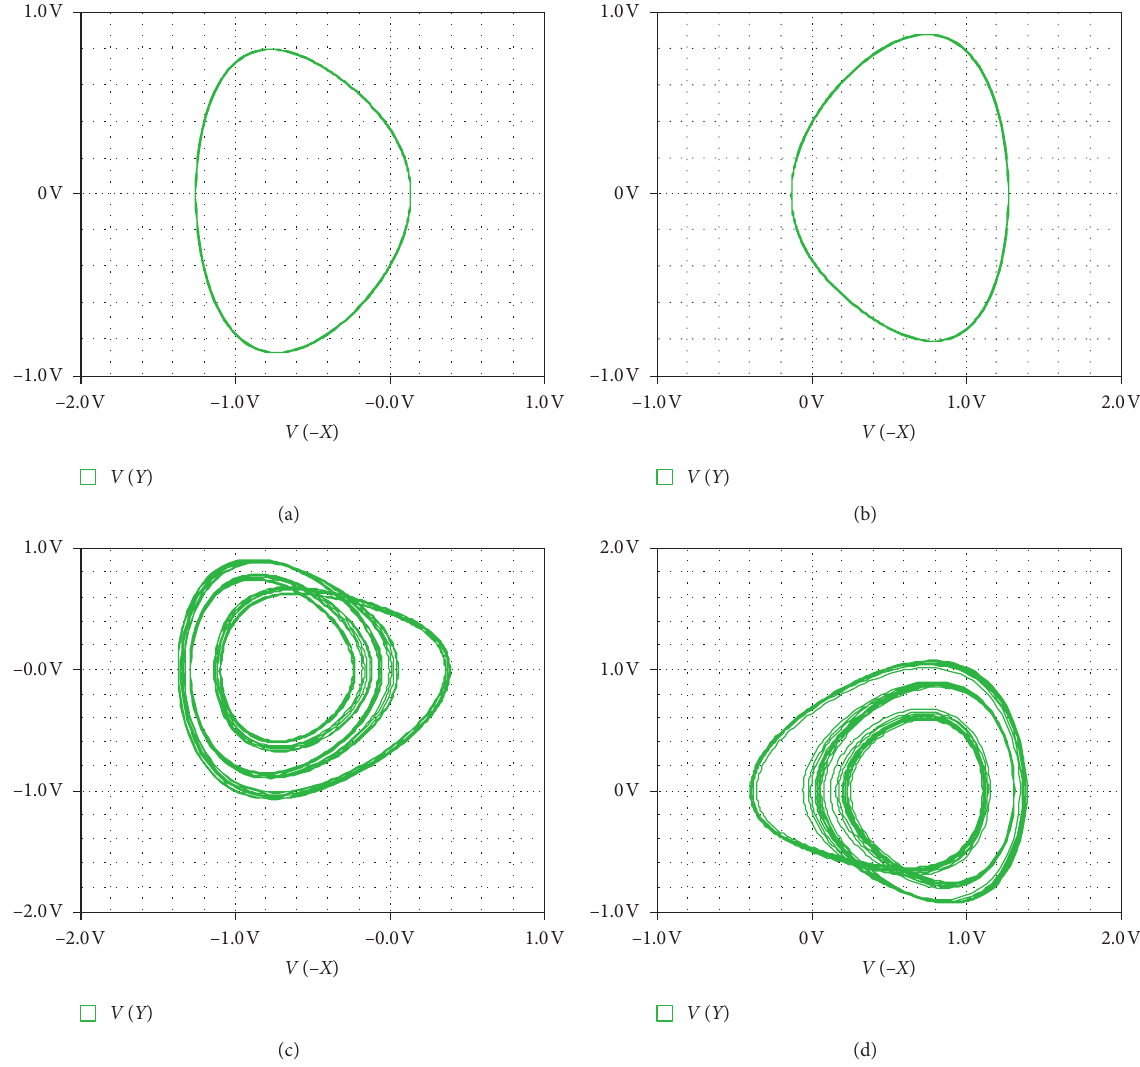
� 1M Ω , R � 3.746k Ω for different values of the initial m k